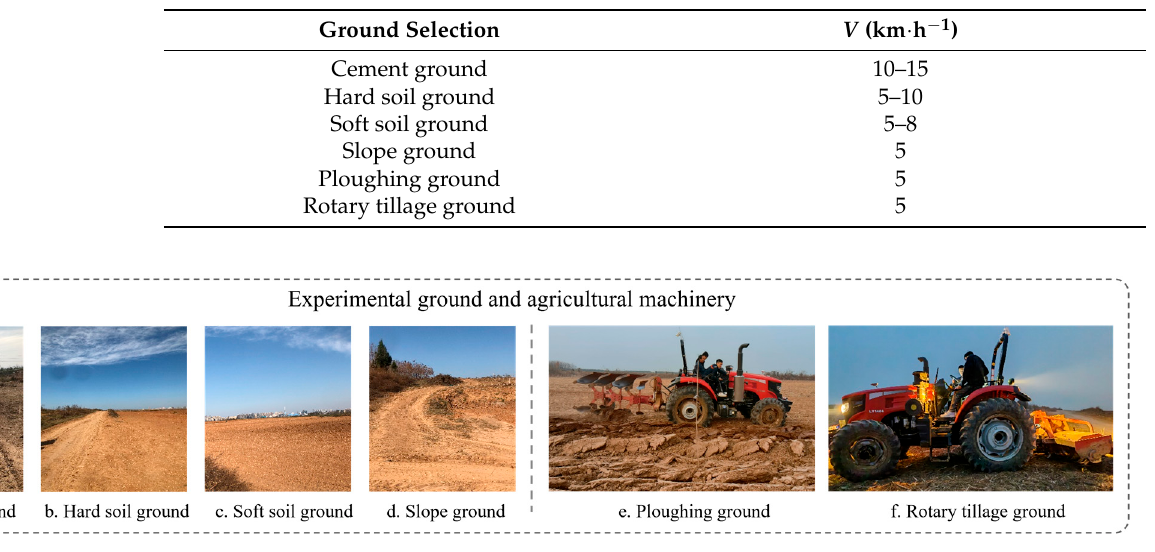
Table 3. Speed of different ground experiments.